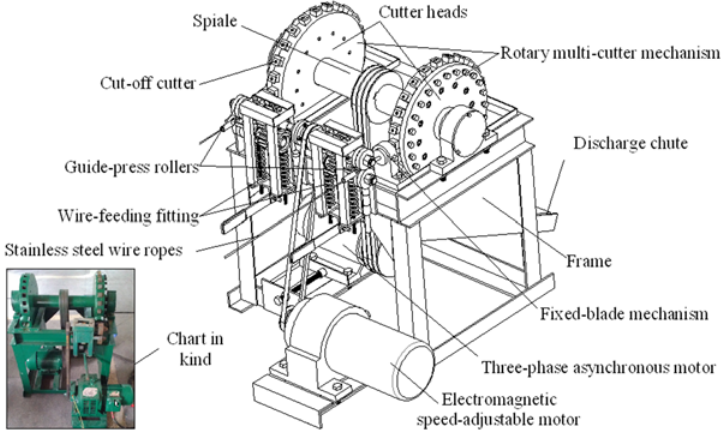
Figure 10. The rotary multi-cutter device to cut off steel wire